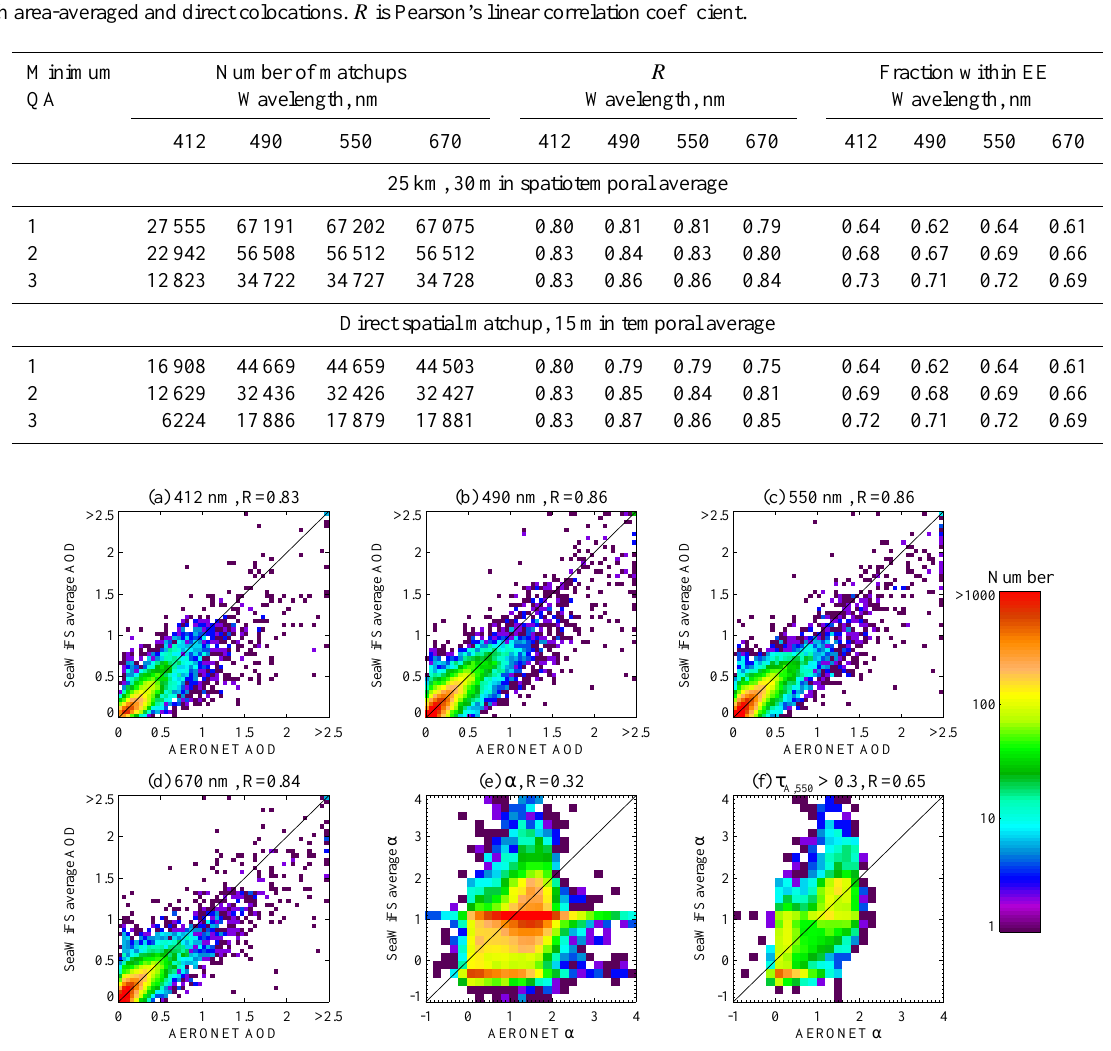
Fig. 2. Scatter density plots between SeaWiFS and AERONET spectral AOD, for (a) 412nm, (b) 490nm, (c) 550nm, (d) 670nm, (e) ˚Angstr¨om exponent (for all points), (f) ˚Angstr¨om exponent (for τ A,550 ≥ 0.3). Only points where QA=3 are included. Correlation coef- ficients are shown above each